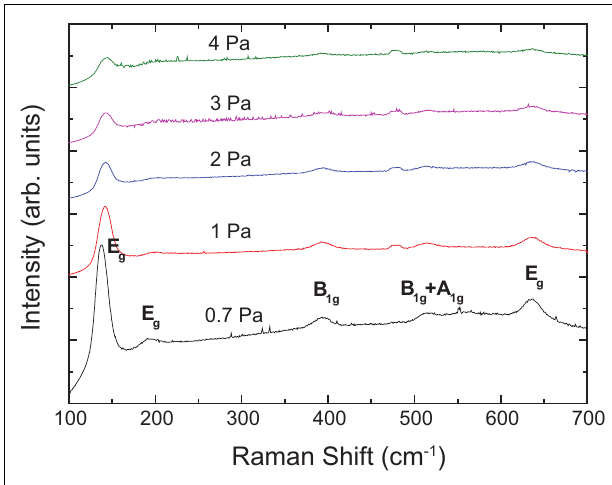
FIGURE 5 | Raman spectra ofTiO 2 films deposited at different sputtering pressures . Peaks associated to anatase phase are indicated.